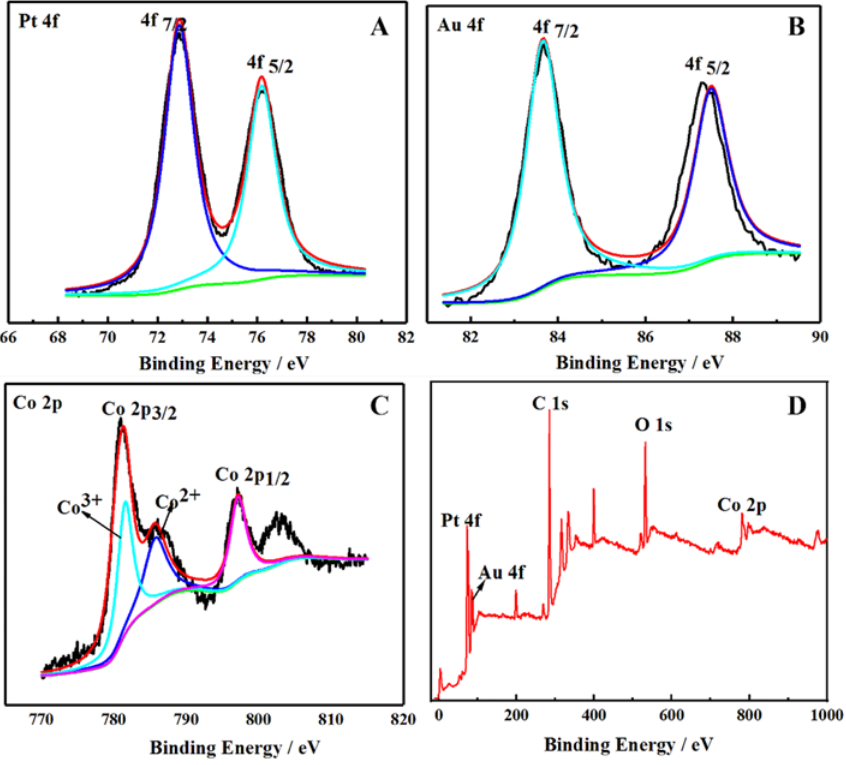
Figure 3. XPS spectra of Pt 4f ( A ), Au 4f ( B ), Co 2p ( C ), and Pt/Au NPs@Co 3 O 4 ( D